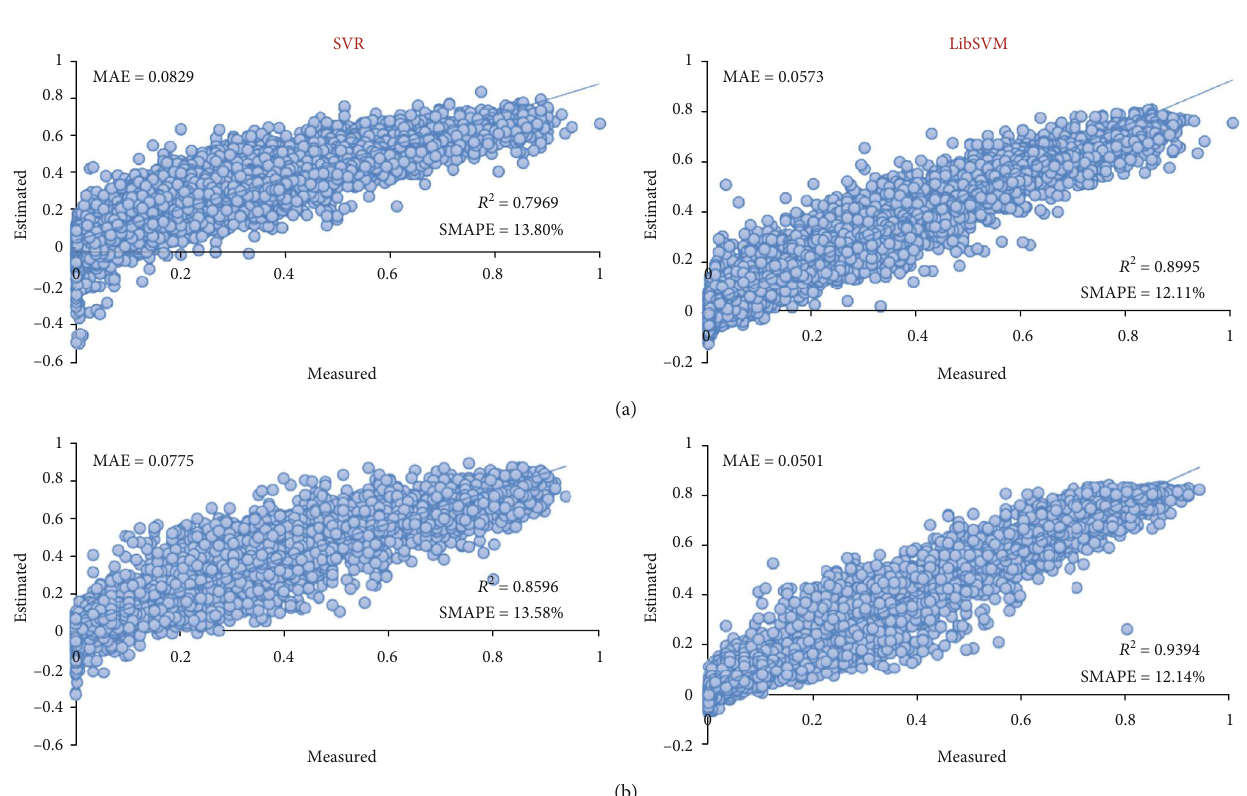
Figure 12: Scatter plots of the most successful models that were developed according to SVR and LibSVM for (a) Isparta and for (b) Kahramanmaras.